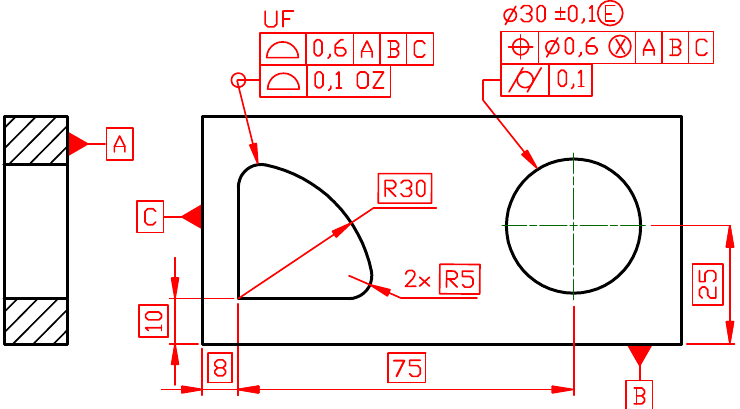
Figure 23. The ISO GPS system specification equivalent to the requirement given in Figure 21.